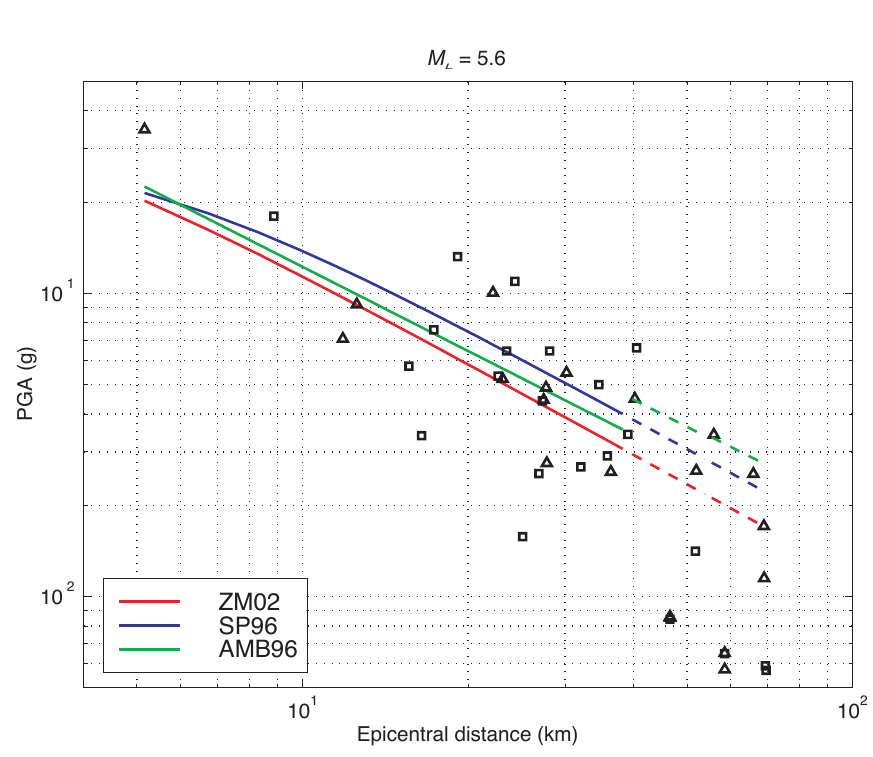
Fig. 7. Different PGA attenuation functions are plotted with respect to epicentral distance for local magnitude M = 5.6. The red line is the curve calculated in this study (ZM02), in blue is SP96 attenuation relationship L and in green is AMB96. Solid lines are for rock sites, while dashed lines are the attenuation relationships for soil. The black symbols represent all the data with M (see table